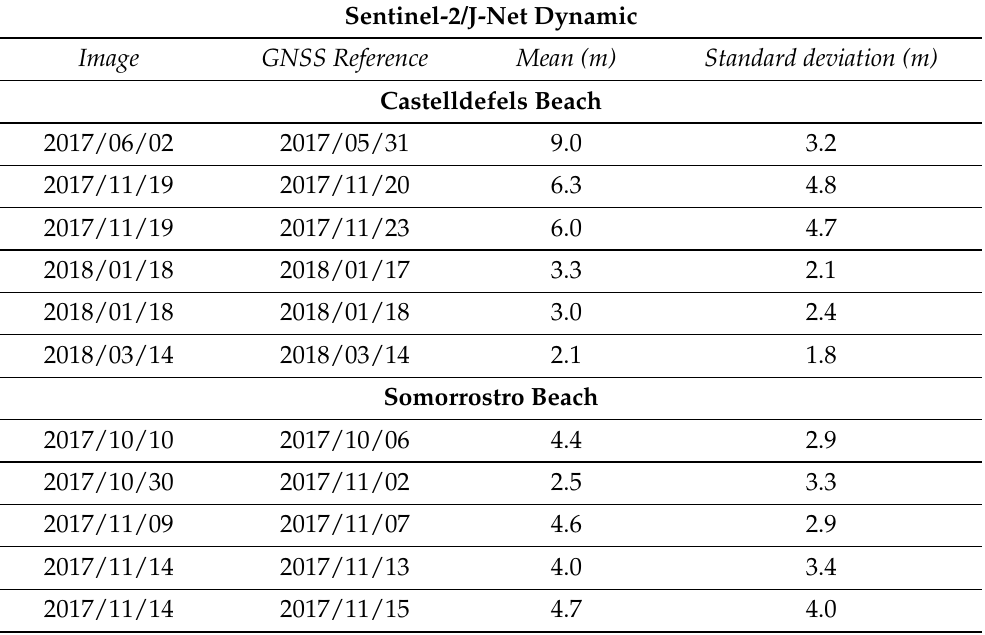
Table 3. Mean and standard deviation of the distances between Sentinel-2 shorelines and GNSS reference points in Castelldefels and in Somorrostro beaches by using the experimental J-Net Dynamic